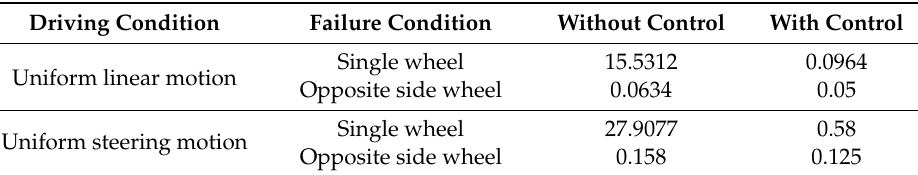
Table 4. Maximum deviation of lateral with or without control (m).